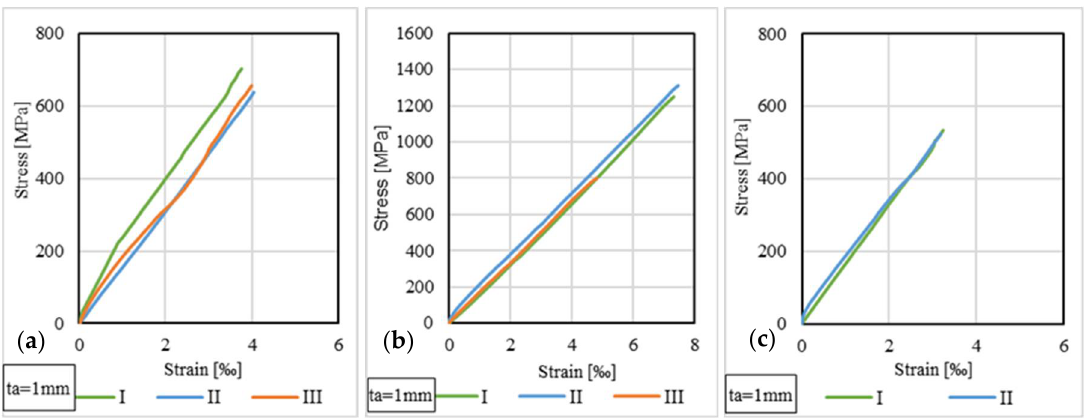
Figure 16. Stress–strain curves for S512 strip: ( a ) S-S512-30-1-I, II, III; ( b ) S-S512-330-1-I, II, III; ( c ) NS-S512-30-1-I, II.